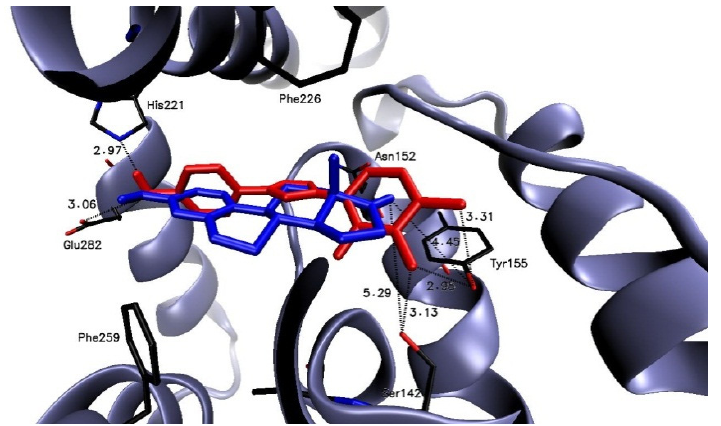
Figure 7. The binding mode of compound 6c (red) and E1 (blue) in the 17 β -HSD1 active site.